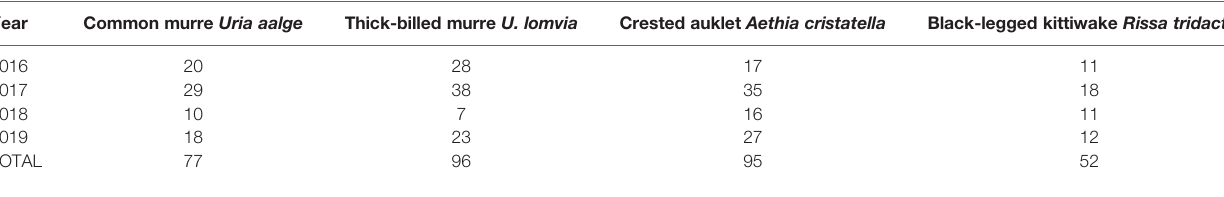
TABLE 4 | Sample sizes available for the isotopic data in each studied species and